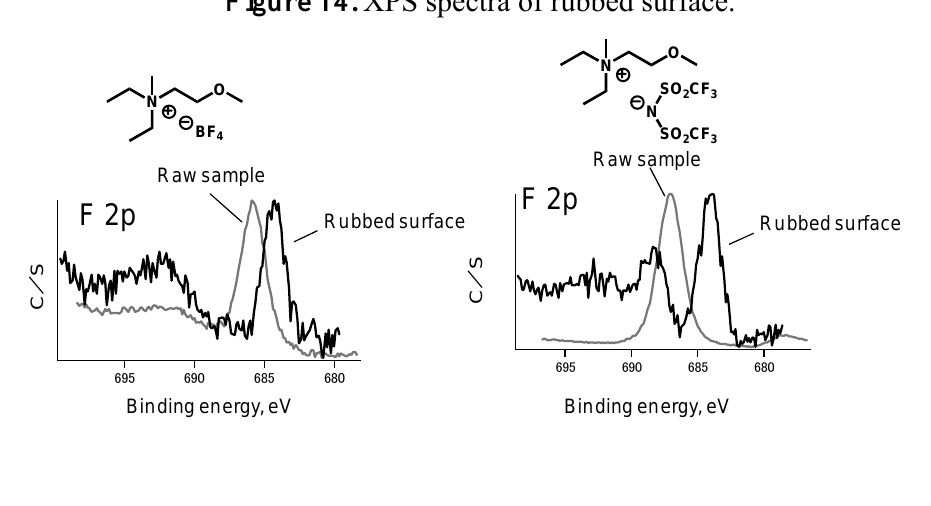
Figure 15. Chemical mapping of rubbed surface by